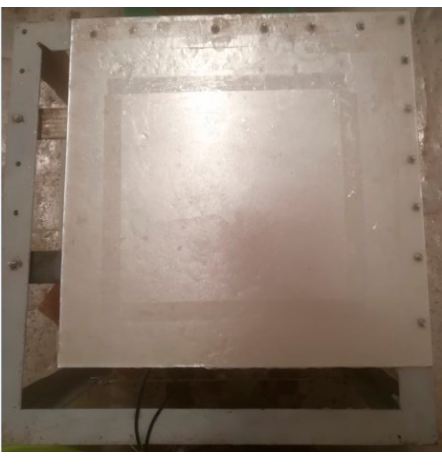
Figure 5. Icing results of the aluminum plate.